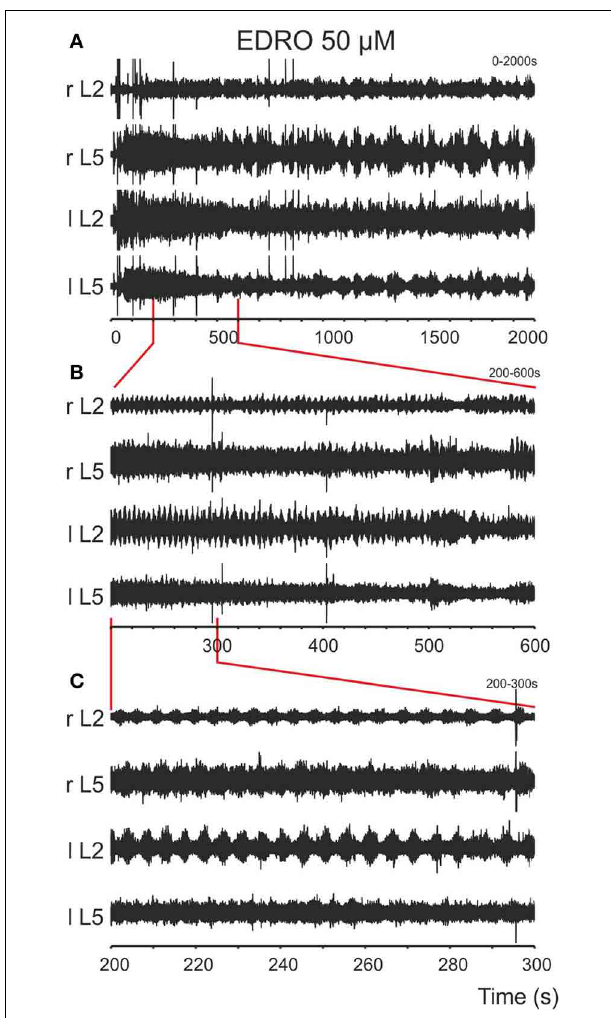
FIGURE 1 | Episodes of rhythmic activity are induced after bath application of EDRO. (A) EDRO applied to the bath 30s after the onset of the recording induced episodes of rhythmic activity with waxing and waning amplitude of the signal in all channels for several minutes. (B) Expanded sample from the same recording showing episodes of rhythmic activity (the area indicated by vertical lines) separated by periods of decreased activity. (C) Expanded sample of the recordings in (B) (the area indicated by vertical lines) showing well-coordinated locomotion characterized by alternating flexor/extensor (L2/L5) and right/left ENG activity